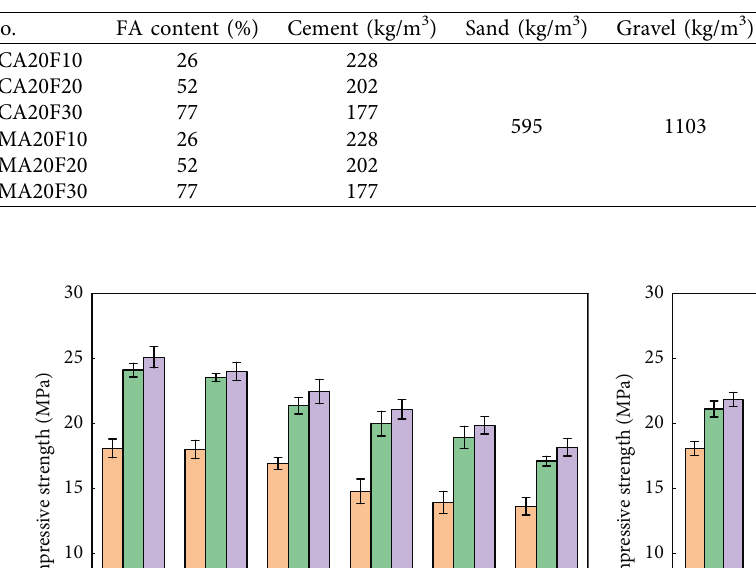
Table 6: The mixing proportion of CCG and CMG.